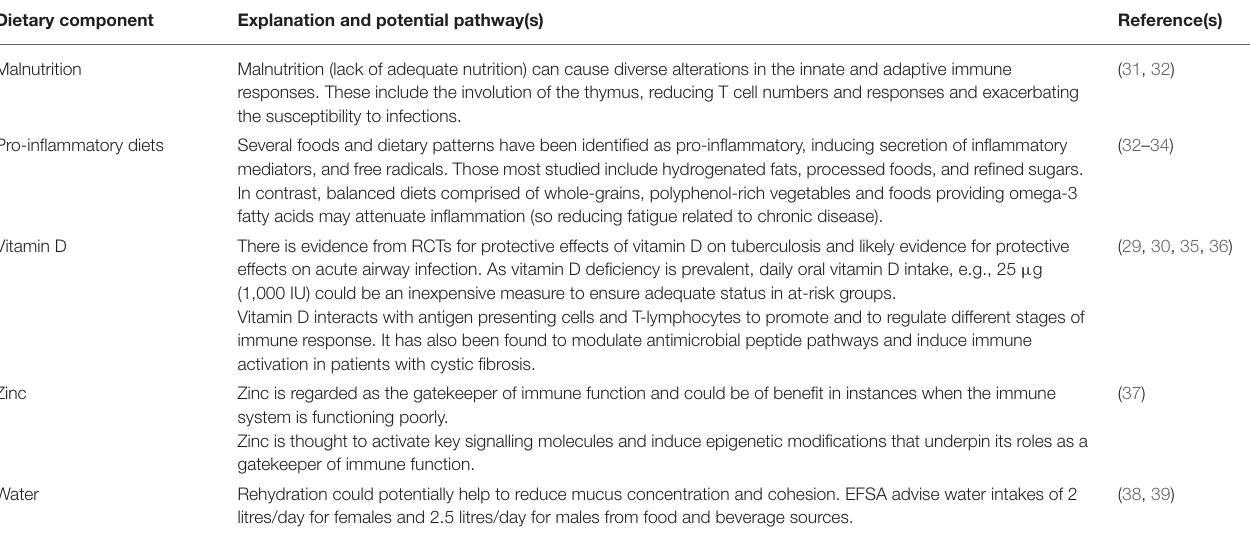
TABLE 1 | Bronchiectasis: potential modifiable nutritional risk factors. Dietary component